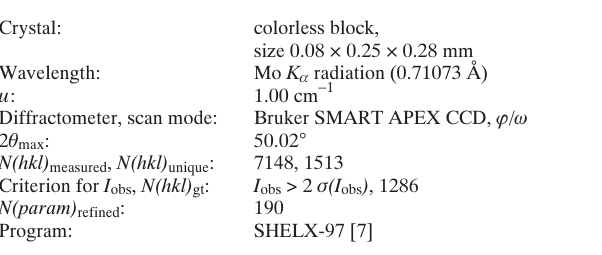
Table 1. Data collection and handling.